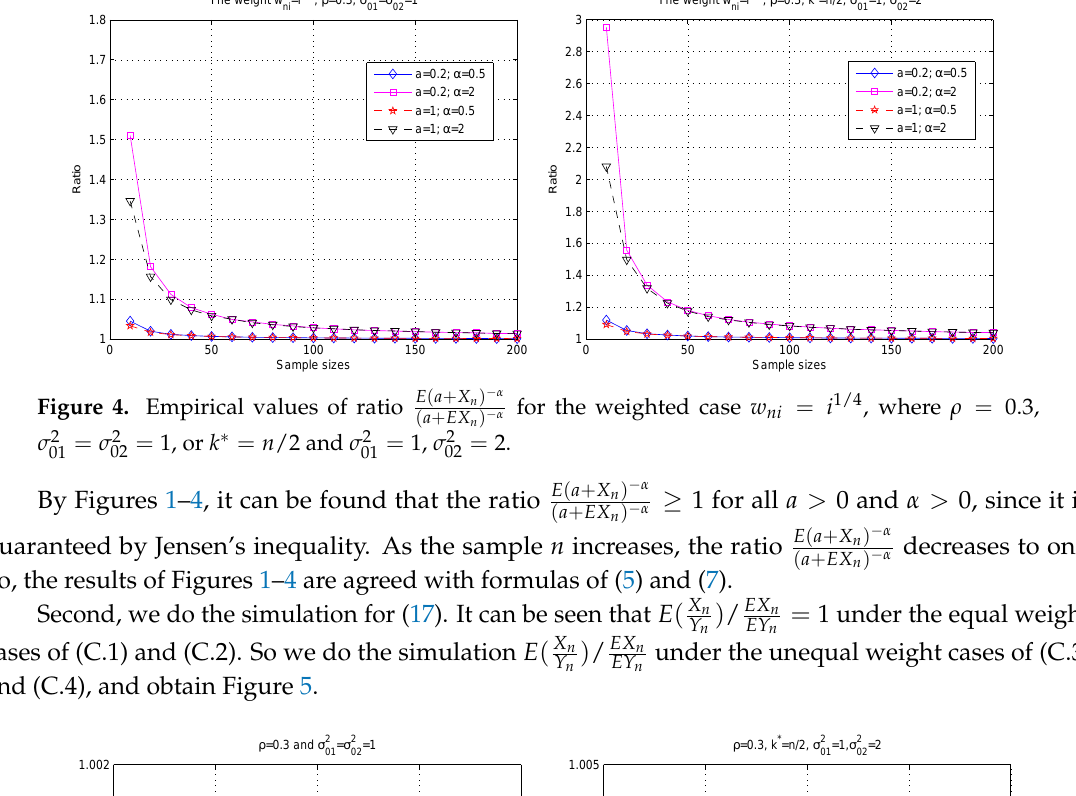
) / EX n for the weighted cases w ni = i − 1 Y n EY n = 1, σ 2 = 02 01